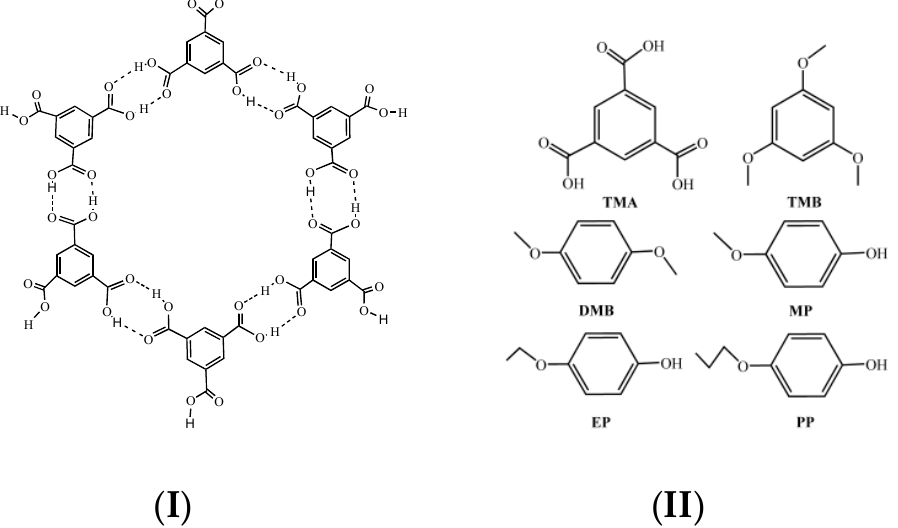
Scheme 1. ( I ) Infinite two-dimensional hydrogen-bonded networks in trimesic acid, ( II ) structures of trimesic acid and phenol